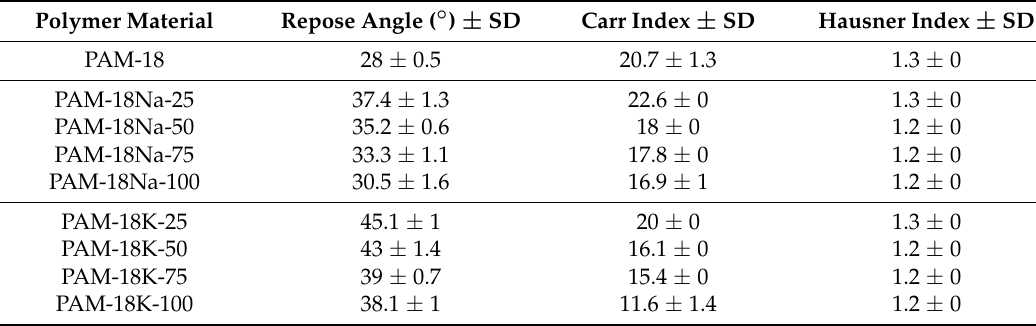
Table 2. Flowability data for polymeric material derived from